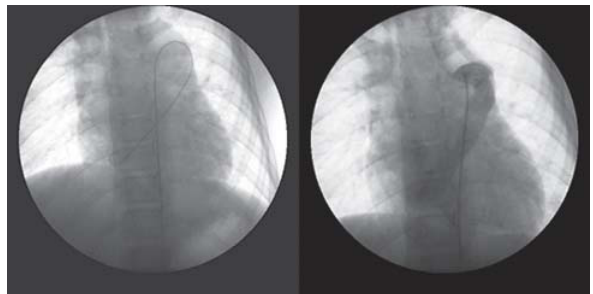
Fig. 1 - Angiografia venosa mostra o cateter-guia e seu trajeto percorrendo a veia hemiázigos e a veia cava superior esquerda persistente, a qual drena no átrio direito através do seio coronariano